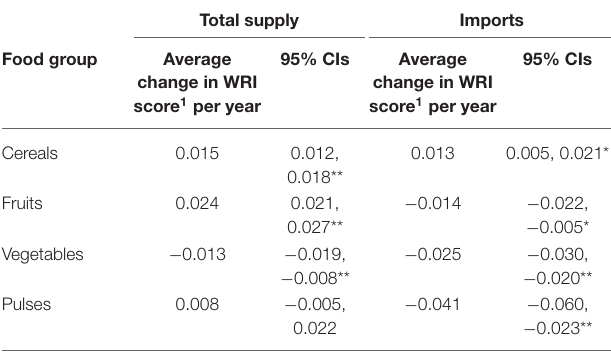
TABLE 2 | Multilevel mixed-effects generalized linear model for weighted-average change in WRI score (projected water stress in 2040) of total supply and imports for cereals, fruits, vegetables and